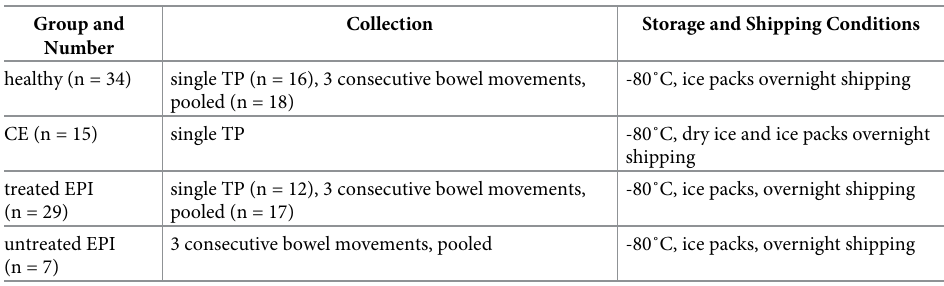
Table 2. Fecal sample collection